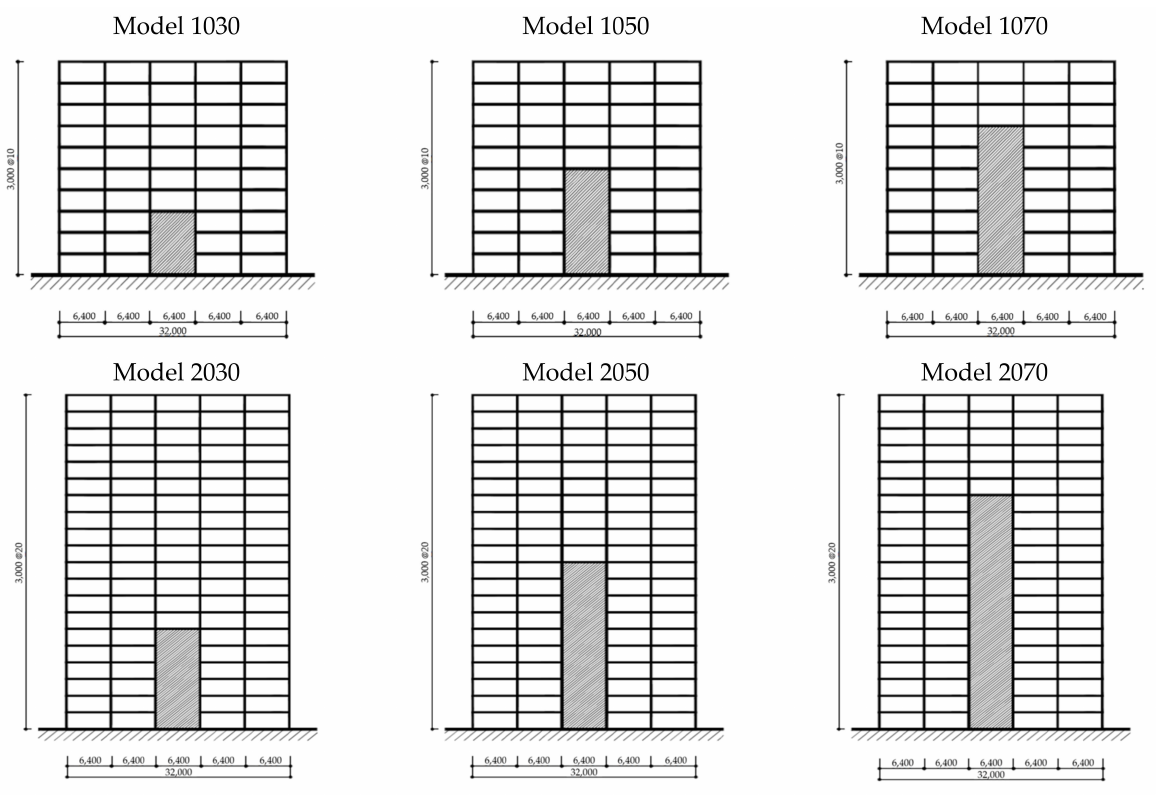
Figure 13. Ten-story ( top ) and twenty-story ( bottom ); 30%, 50%, and 70 % of curtailed shear wall (in mm). Table 1. Structural parameters of RC columns.